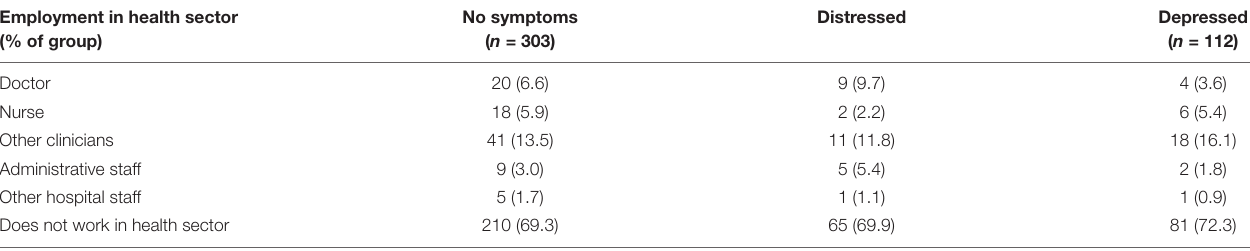
TABLE 4 | Rate of distress and depression by employment in health care sector. Employment in health sector (% of group)